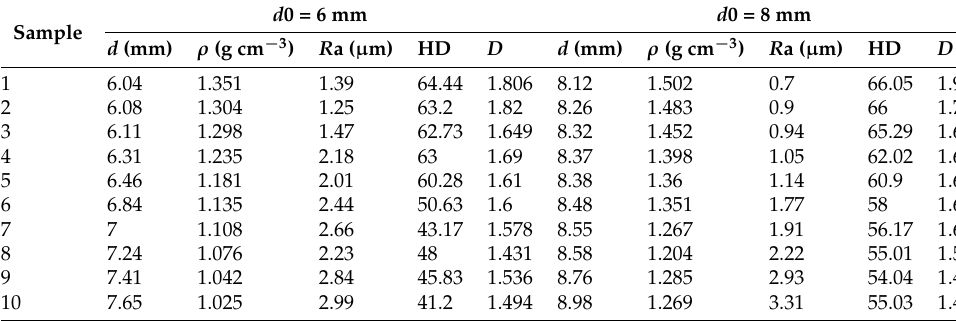
Table 1. Analysis of influencing factors on fractal parameters of biomass